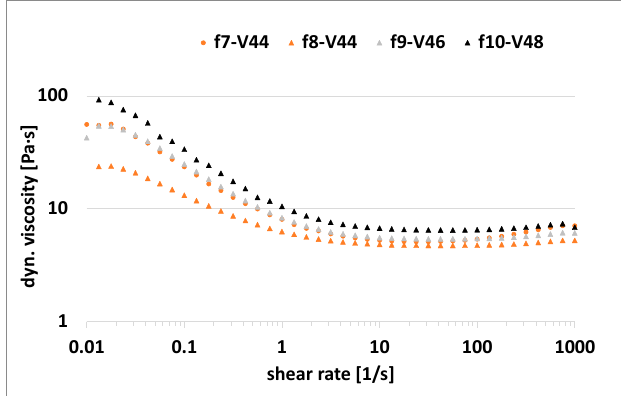
Figure 3. Dynamic viscosity to shear rate; AlN content of 44 (f7) and 44 to 48 vol% with increased dispersant content (f8–f10).